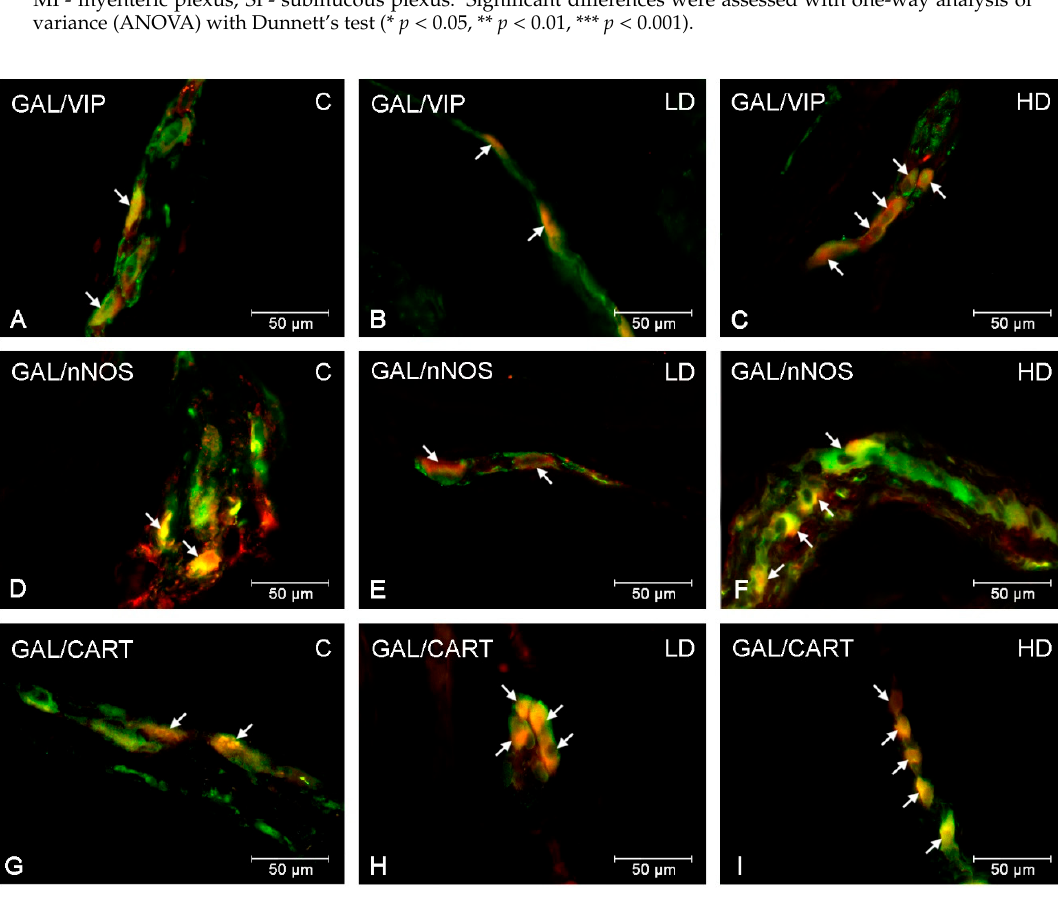
Figure 3. Co-localization of GAL with VIP, nNOS and CART in myenteric plexuses in the porcine stomach. The most representative images showing changes in the degree of co-localization of GAL with VIP in the myenteric plexuses of the cardia ( A , B , C ); GAL with nNOS in the myenteric plexuses of the pylorus ( D , E , F ); GAL with CART in the myenteric plexuses of the pylorus ( G , H , I ). Photographs A, D, G showing myenteric plexuses in the physiological conditions; B, E, H—after low and C, F, I after high doses of acrylamide administration. All photographs have been created by digital superimposition of two color channels (green for GAL and red for VIP, nNOS and CART respectively). Neurons immunoreactive to GAL and VIP or nNOS or CART are indicated with arrows.